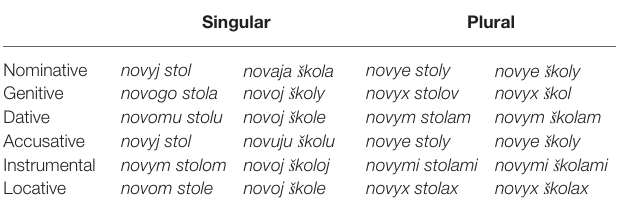
TABLE 1 | Paradigms of the noun phrases novyj stol “new table M ” and